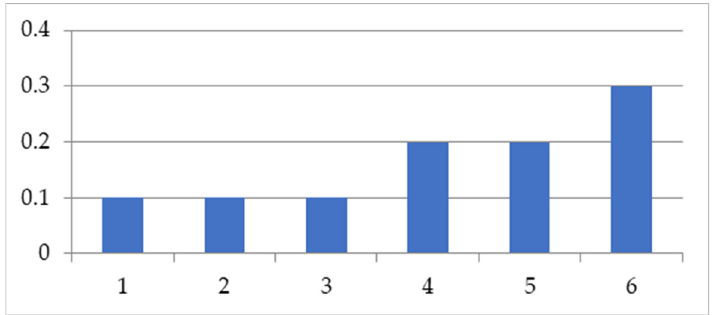
Figure 5. The histogram of PMF discrete nonuniform distribution. Data source: Cross Validated [48].